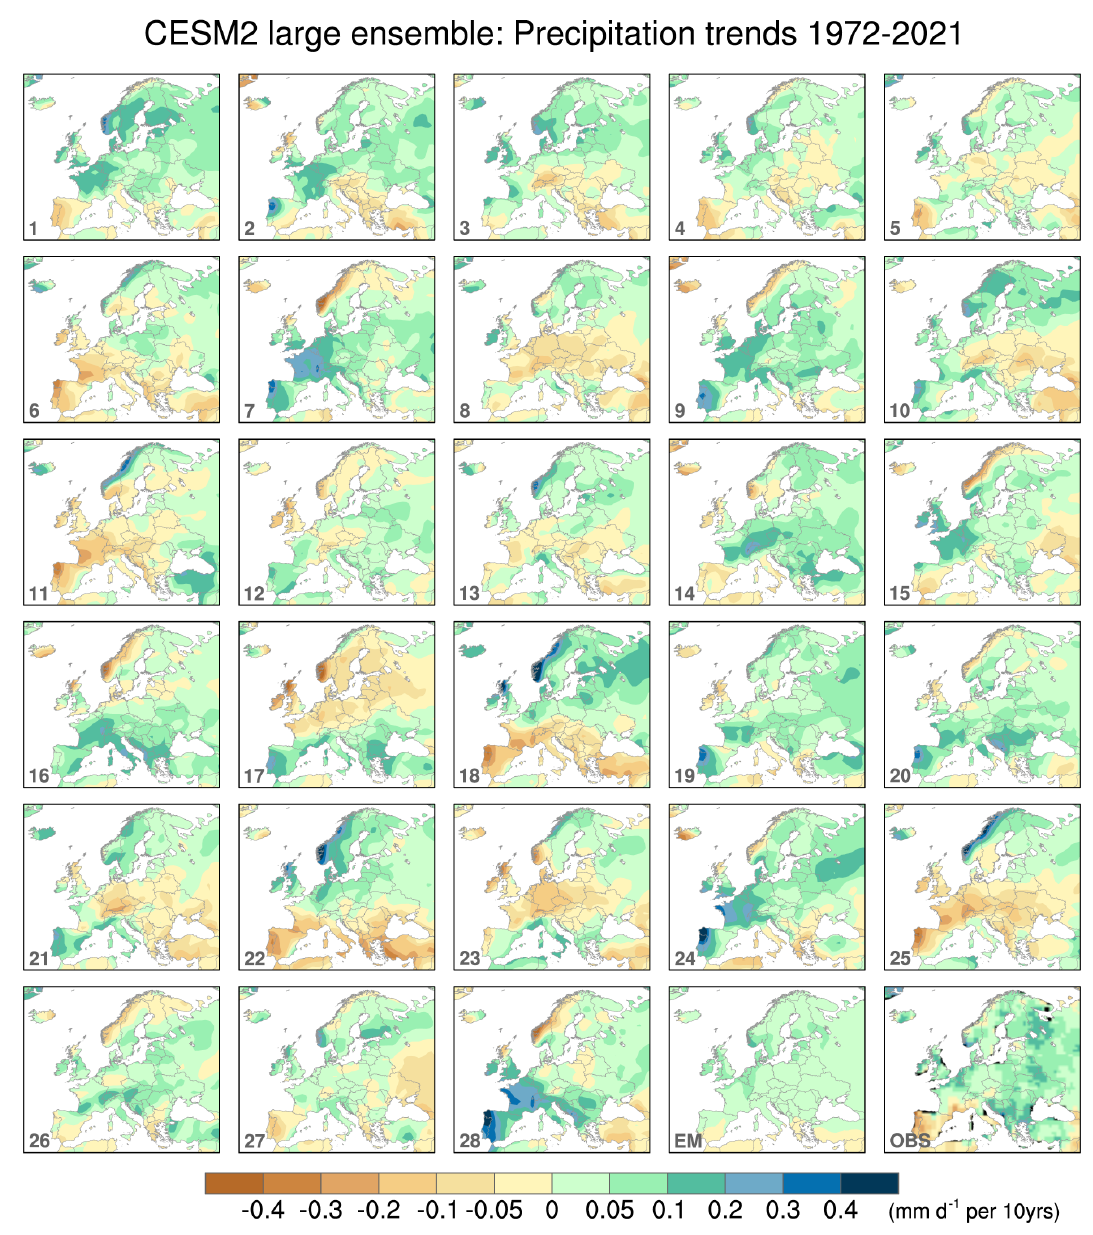
Figure 2. As in Fig. 1 but for precipitation (mmd − 1 per